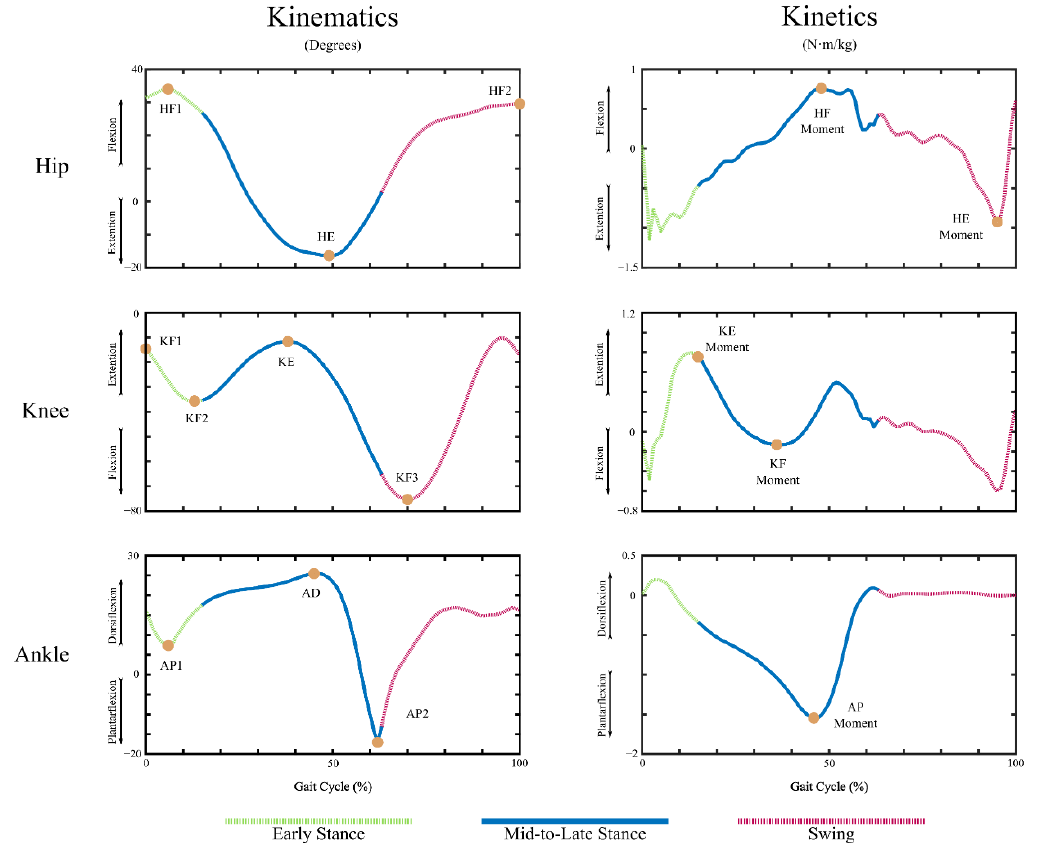
Figure 1. Kinematic and kinetic peak metrics marked on top of gait kinematics and kinetics of a representative trial. Gait kinematics and kinetics have been color-coded to reflect Early Stance (green), Mid-to-Late Stance (blue), and Swing (red) phases. Full metric names and their abbreviations are as follows: Stance Maximum Hip Flexion (HF1), Stance Maximum Hip Extension (HE), Swing Maximum Hip Flexion (HF2), Maximum Knee Flexion during Initial Contact (KF1), Stance Maximum Knee Flexion (KF2), Mid to Late Stance Maximum Knee Extension (KE), Swing Maximum Knee Flexion (KF3), Stance Maximum Ankle Plantarflexion (AP1), Maximum Ankle Dorsiflexion (AD), Maximum Ankle Plantarflexion (AP2), Stance Maximum Hip Flexion Moment (HF Moment), Swing Maximum Hip Extension Moment (HE Moment), Stance Maximum Knee Extension Moment (KE Moment), Mid-to-Late Stance Maximum Knee Flexion Moment (KF Moment), and Maximum Ankle Plantarflexion Moment (AP Moment).